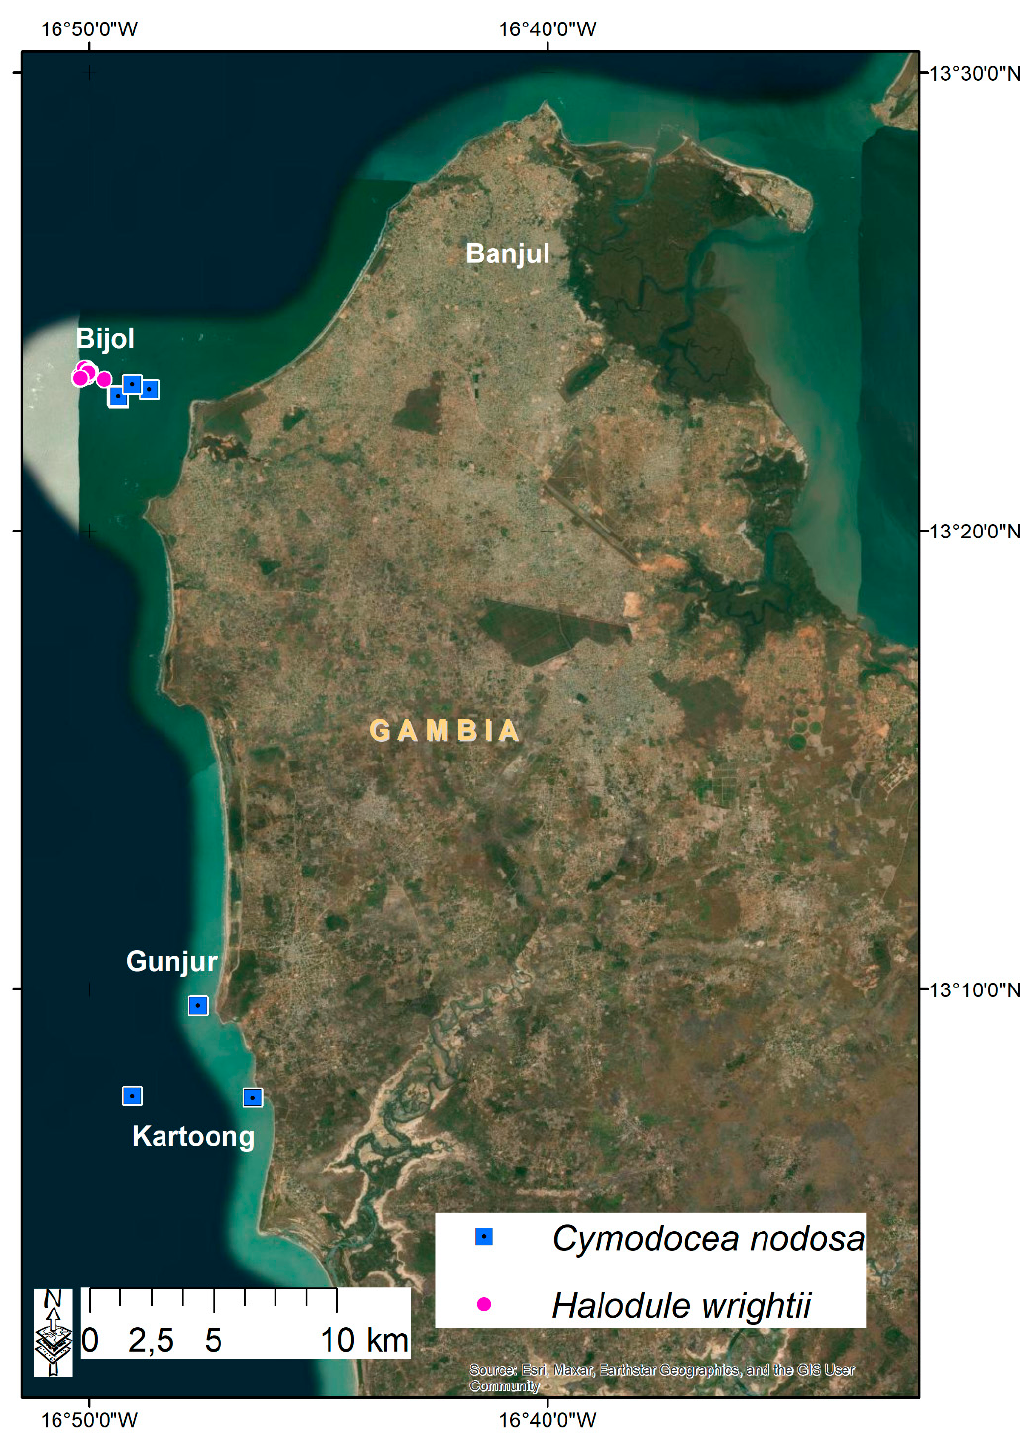
Figure 4. Seagrass distribution in The Gambia.